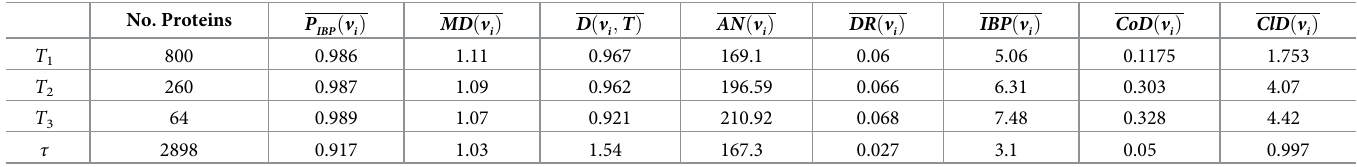
Table 1. The first column shows the number of proteins for each selected set and the total number of vertices for set τ . The next columns show the average values obtained for each feature in each of the selected set.( X denotes the average